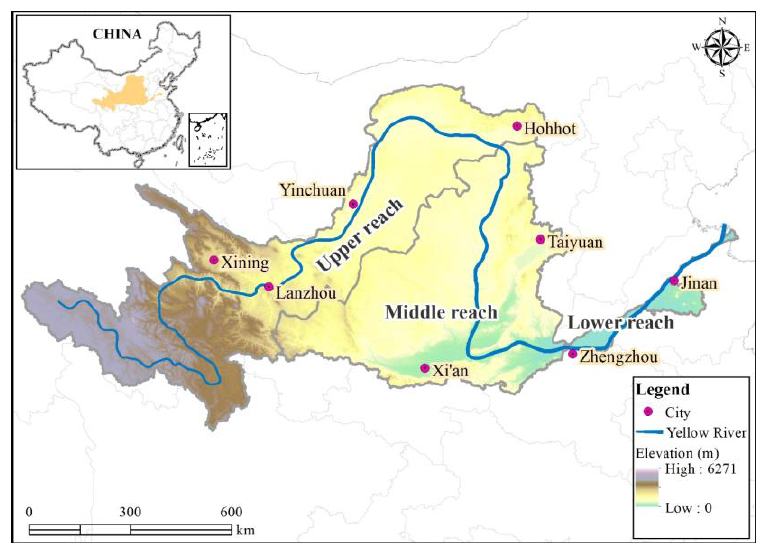
Figure 1. The study area of Yellow River Basin.